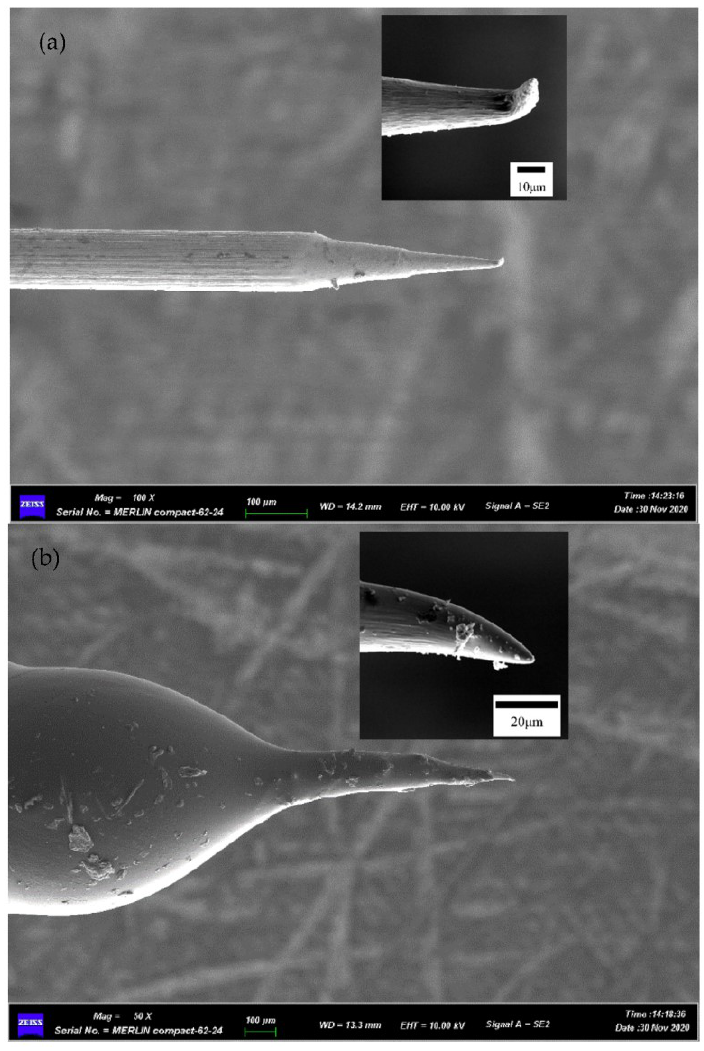
Figure 2. SEM images of the conically shaped tungsten microelectrode etched in 3 M KOH solution, including ( a ) the bare microelectrode and ( b ) the asphalt-covered microelectrode. The inserted images were with high magnification.